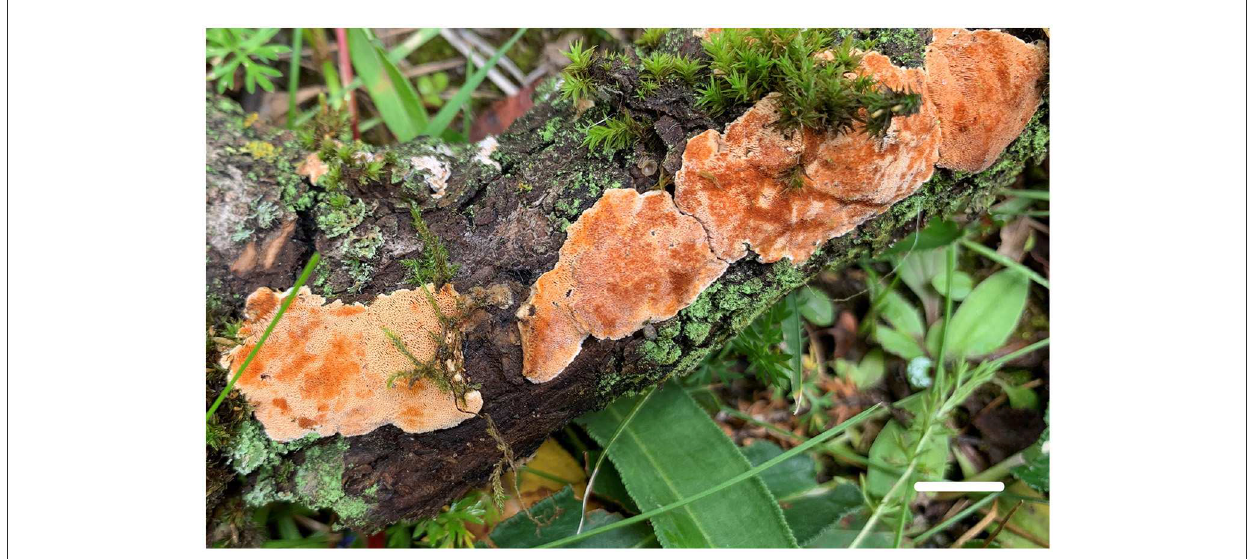
FIGURE4 Basidiomata of Steccherinum juniperi (Paratype, Dai 23930) (Scale bar = 1.0cm). Photographed by Yu-Cheng Dai.